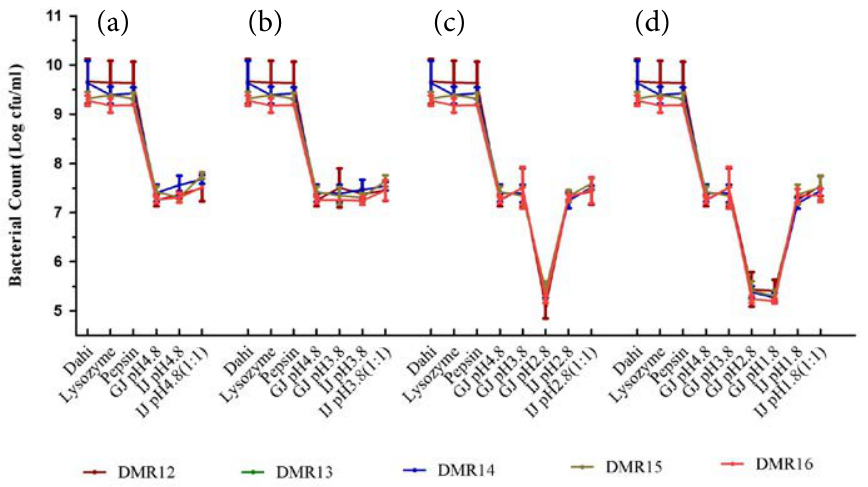
Fig. 7. Microbial count (cfu/g) of LAB isolates after exposure to different stress conditions prevailing during oro- gastric intestinal transit. Each figure represents a stress condition up to a particular pH and then exposed to intestinal stress (a) up to pH 4.8 and then exposed to intestinal stress, (b) up to pH 3.8 and then exposed to intestinal stress, (c) up to pH 2.8 and then exposed to intestinal stress, (d) Stress up to pH 1.8 and then exposed to intestinal